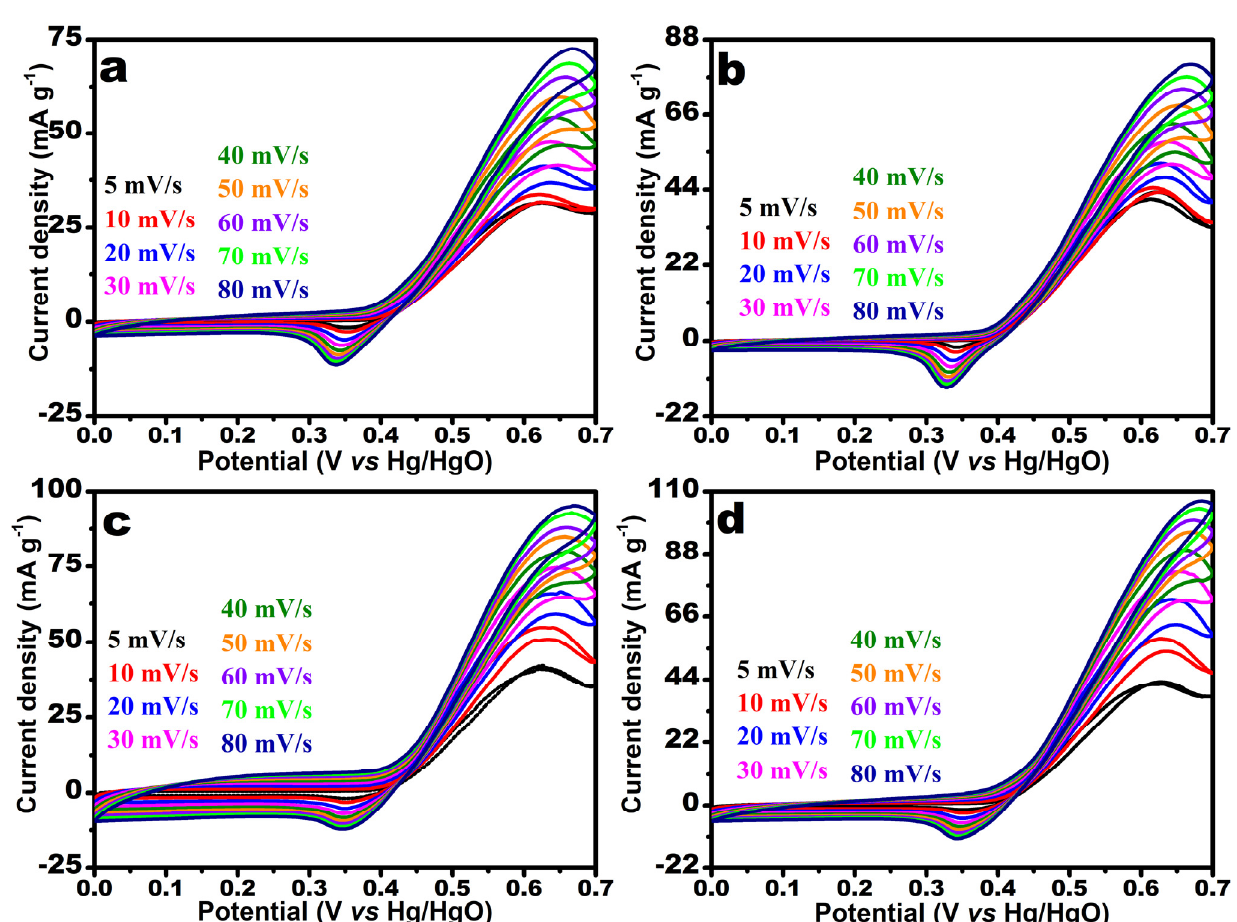
Figure 8. CV curves of the electrocatalysts of UOR analysis at various scan rates; MW-7 ( a ), MW-12 ( b ), MW@GO-7 ( c ), and MW@GO-12 ( d ).